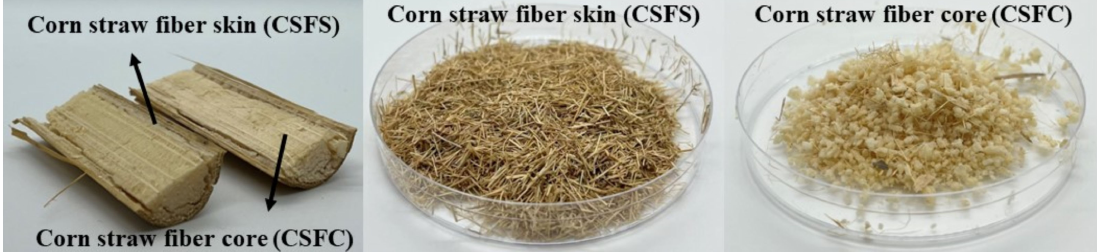
Figure 1. The appearance of CSF, CSFS and